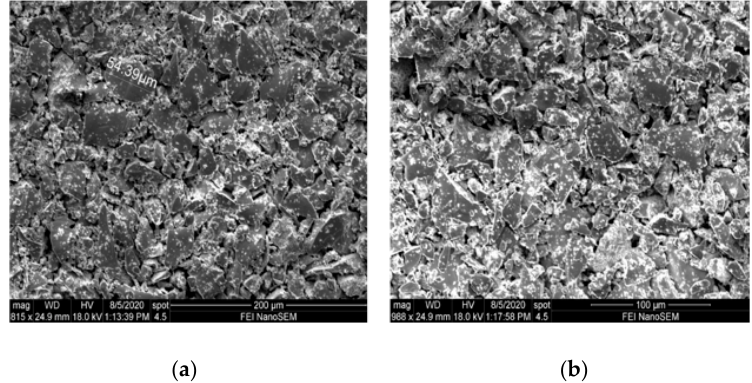
Figure 11. SEM images of ( a ) Terfenol-D nanoparticles before chemical treatment and ( b ) Terfenol-D nanoparticles after chemical treatment.